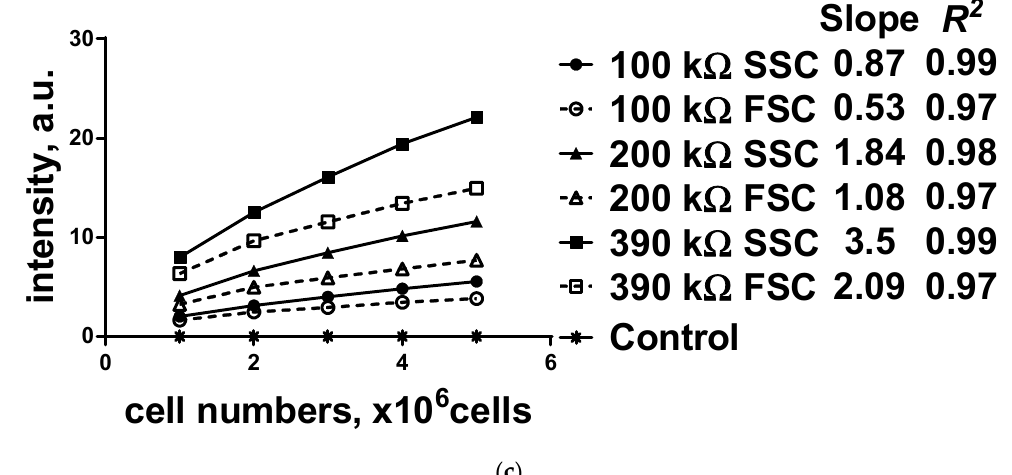
Figure 6. Comparison of the SSCs and FSCs of the fluorescence intensities of HeLa cells using one of the three different load resistors (100, 200, and 390 k Ω ) with a specific filter set: ( a ) no excitation filter, but only emission filter (center wavelength (CWL) at 500 nm); ( b ) excitation filter of CWL at 480 nm with emission filter of CWL at 500 nm; ( c ) excitation filter of CWL at 470 nm with emission filter of CWL at 500 nm. RSD (%) was calculated for each concentration group of stained HeLa cells with one of the selected load resistors.